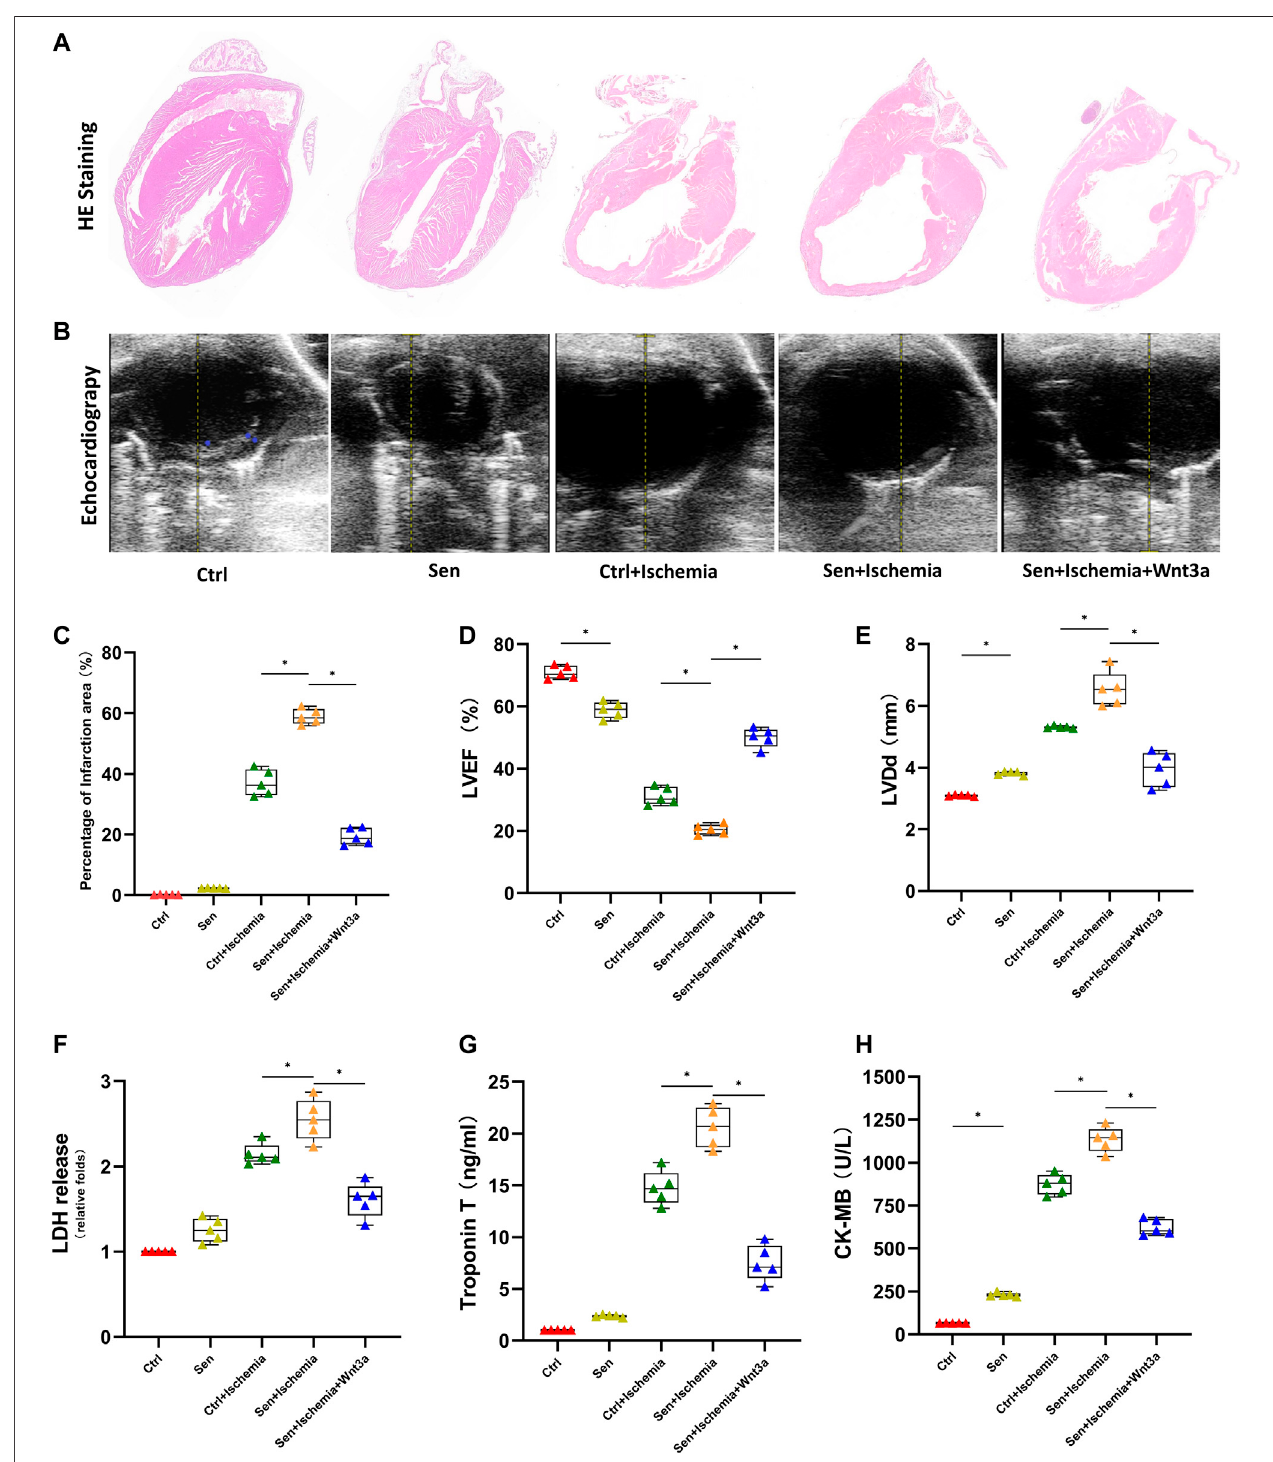
FIGURE 1 | Effects of Wnt 3a on structural, functional and enzymatic changes of senile AMI hearts. Representative HE stained images of the hearts of mice in different groups. The Sen + Ischemia + Wnt3a group demonstrated that the cardiomyocyte structure and left ventricular free wall were improved to some extent compared with the Sen + Ischemia group (A) . Representative M-mode images by echocardiography in different groups, the Sen + Ischemia + Wnt3a group showed signi fi cantly improved cardiac function compared with Sen + Ischemia group (B) . Statistical analysis of the hearts of mice in different groups, the Sen + Ischemia + Wnt3a group demonstrated approximately 20% infarct size decrease due to ischemic injury than that in the Sen + Ischemia group ( p < 0.05) (C) . Statistics of LVEF (D) ,